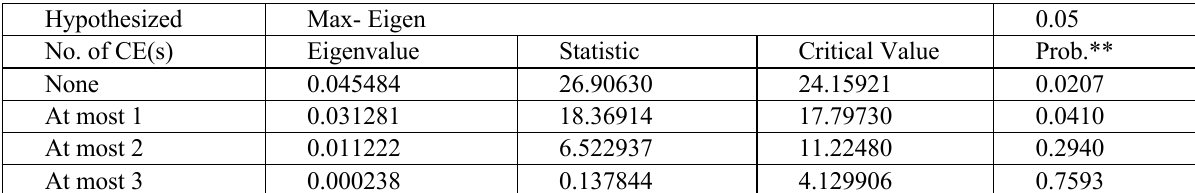
Table 5. Unrestricted Cointegration Rank Test (Maximum Eigenvalue) Source: Authors’